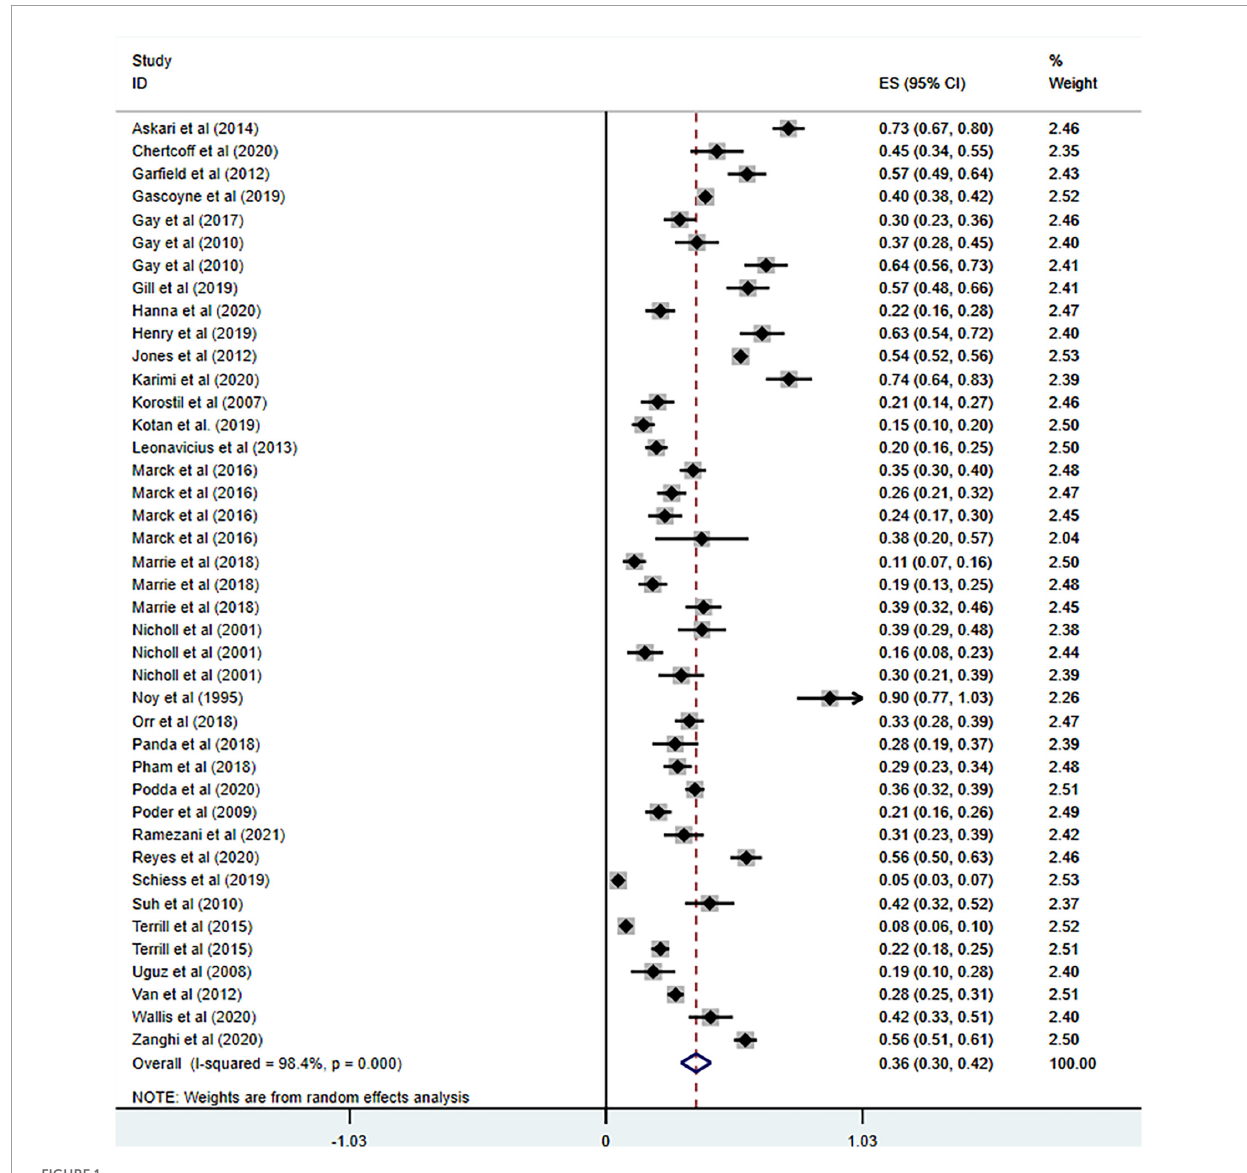
FIGURE1 Forest plot of meta-analysis on prevalence of anxiety in MS